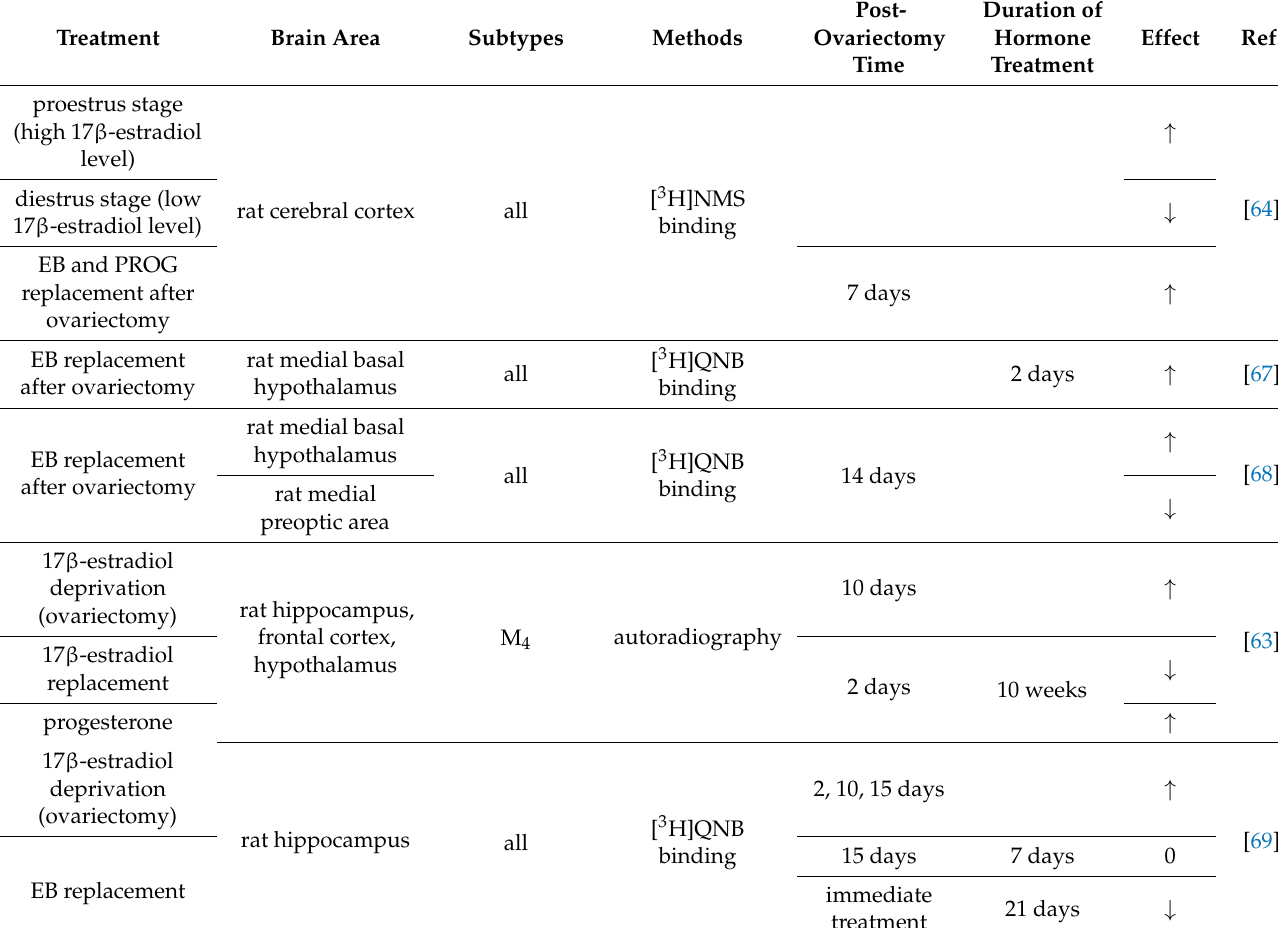
Table 2. Effects of steroids on the expression level of